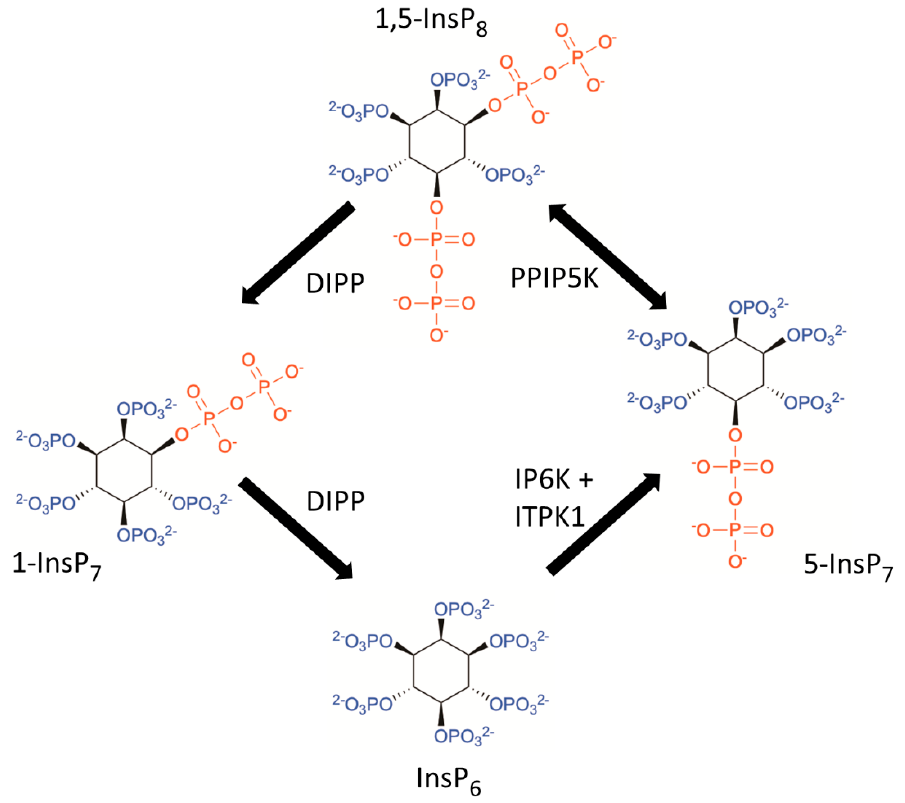
Figure 1. The inositol pyrophosphate (PP-InsP) metabolic pathway. This graphic incorporates a proposal [1,2] that the pathway for 1,5-InsP 8 turnover principally comprises a cyclical interconversion of InsP 6 , 5-InsP 7 , 1,5-InsP 8 , and 1-InsP 7 . ITPK1 = inositol 3,4,5,6-tetrakisphosphate 1-kinase; IP6K = inositol hexakisphosphate 5-kinase; PPIP5K = diphosphoinositol pentakisphosphate 1-kinase (in addition to hosting a self-contained kinase domain, this class of enzyme also contains a phosphatase domain that possesses 1,5-InsP 8 1-phosphatase activity [2–4]); DIPP = diphosphoinositol polyphosphate phosphatase.